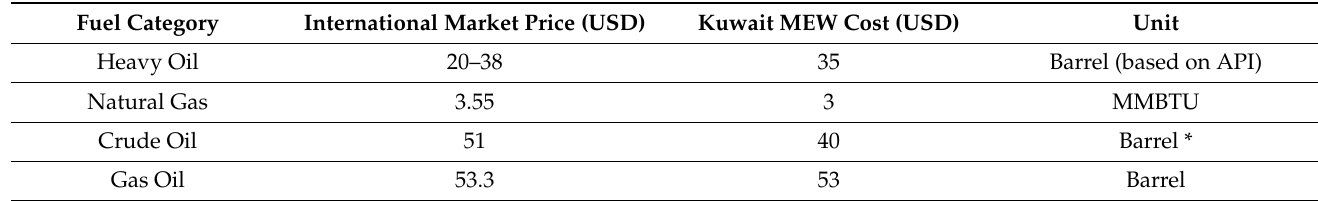
Table 2. International market prices and Kuwait’s MEW cost prices of fuels used in power stations for the year 2016. Source: IEA [30], MEW [32], and Lazard